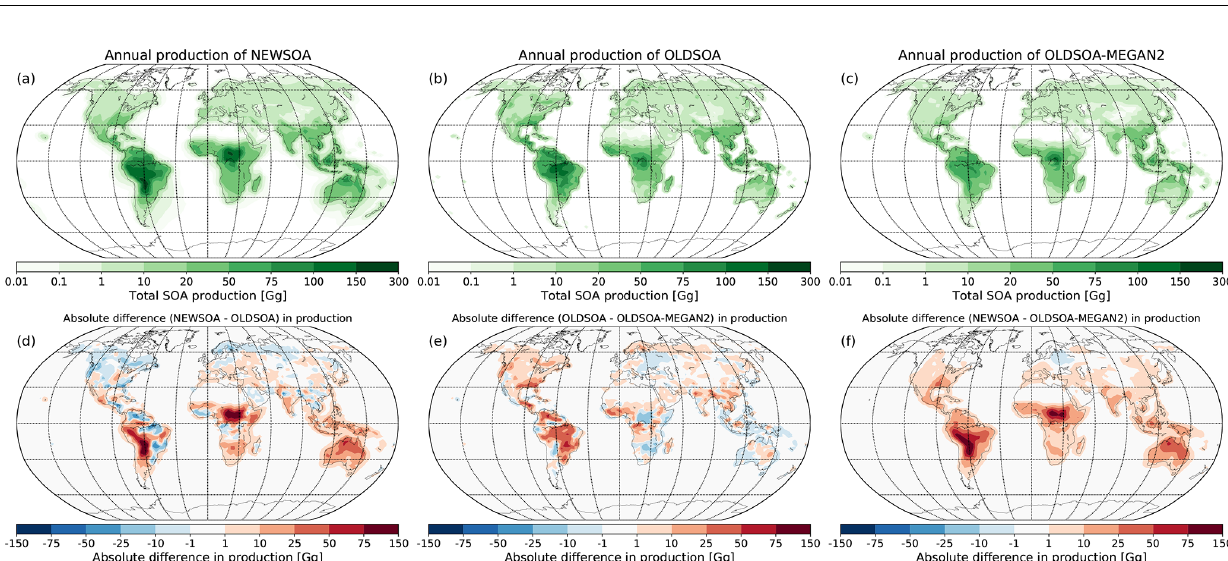
Figure 4. Annual mean production of SOA in NEWSOA (a) , OLDSOA (b) and OLDSOA-MEGAN2 (c) as well as the absolute difference in the global annual production of SOA between simulations NEWSOA and OLDSOA (d) , OLDSOA-MEGAN2 and OLDSOA (e) , and NEWSOA and OLDSOA-MEGAN2. In the difference plots red areas indicate increased production in NEWSOA compared to OLDSOA.